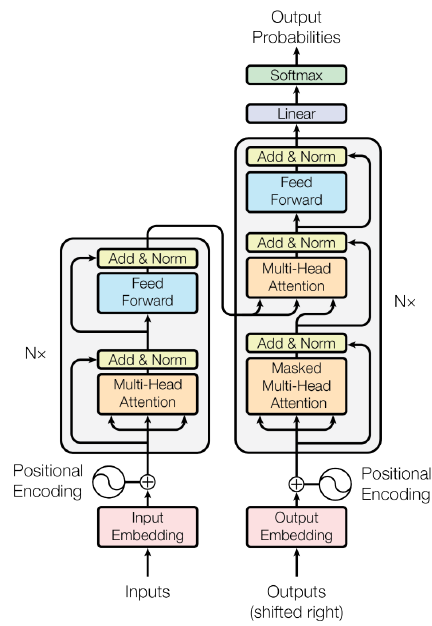
Figure 1. Transformer architecture